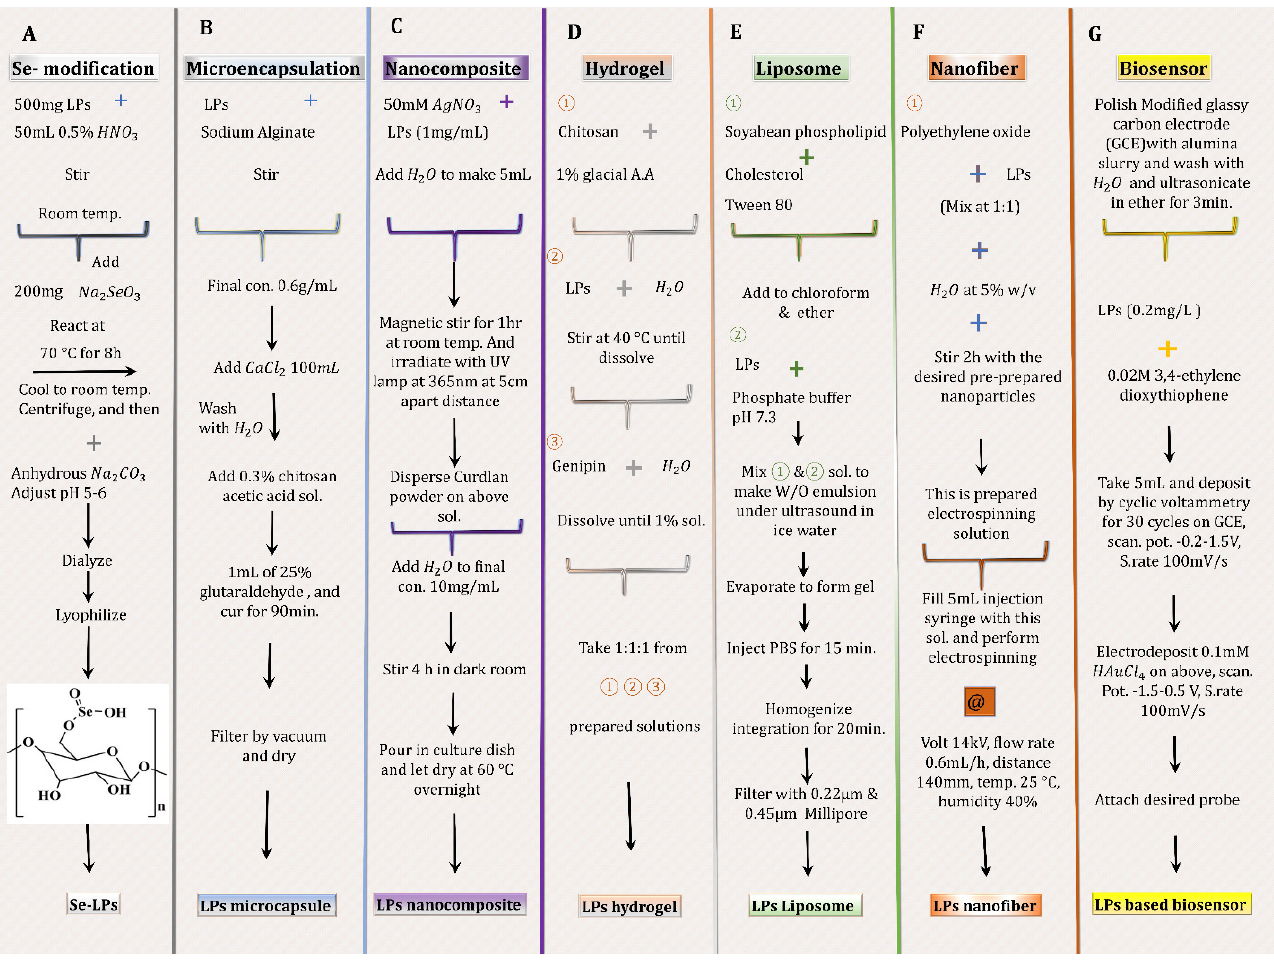
Figure 4. Some methods of formulation using licorice polysaccharides. Formulation method, quan- tities and conditions are retrieved from: ( A ) : selenium modification [101]; ( B ): LPs microencapsula- tion [40]; ( C ): LPs nanocomposite [105]; ( D ): LPs based hydrogel [106]; ( E ): LPs liposome [107]; ( F ): LPs nanofiber [109]; G : LPs based biosensor [111].